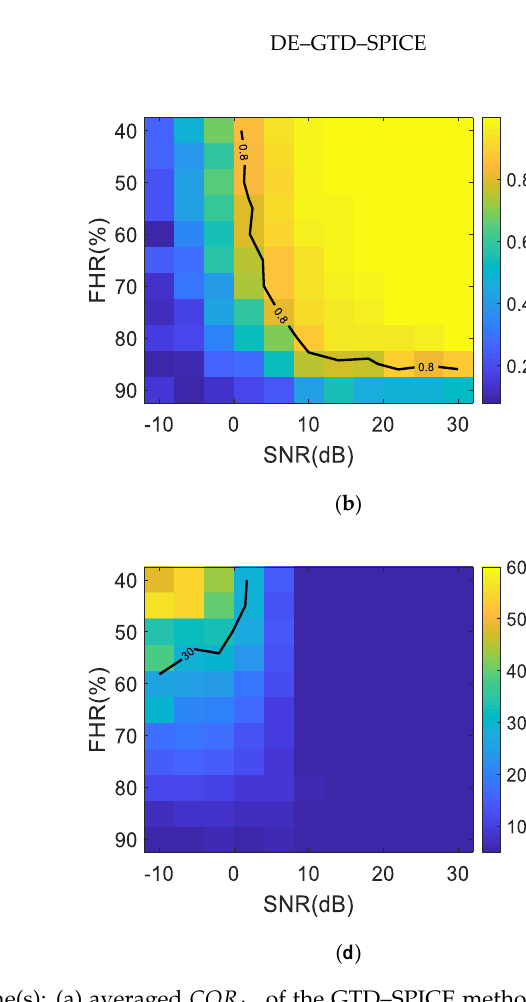
of the GTD–SPICE method, (b) yy